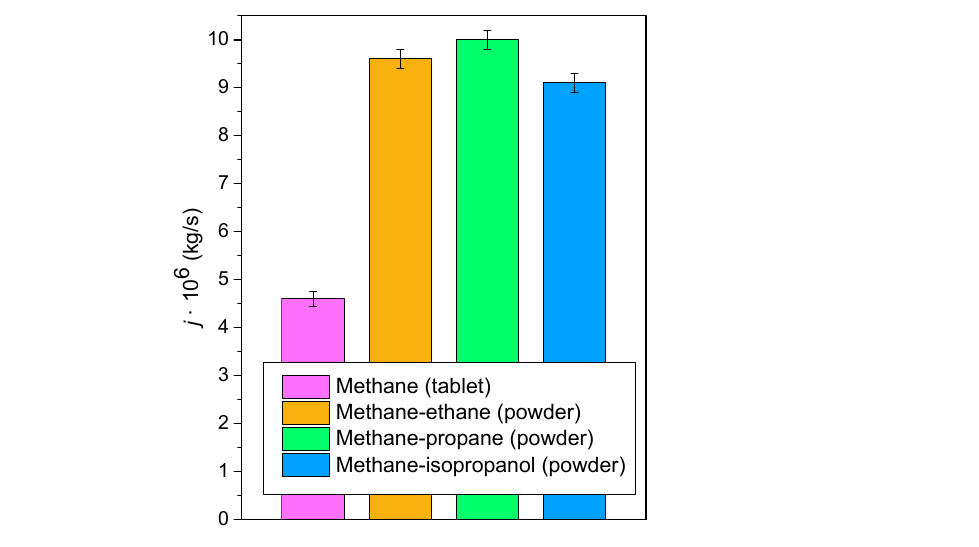
Figure 4. The dissociation rate j of gas hydrates burning in a high-temperature furnace (the initial thickness of the powder layer is 16 mm, the initial thickness of tablet is 5 mm, the furnace temperature is 1373 K) [50].